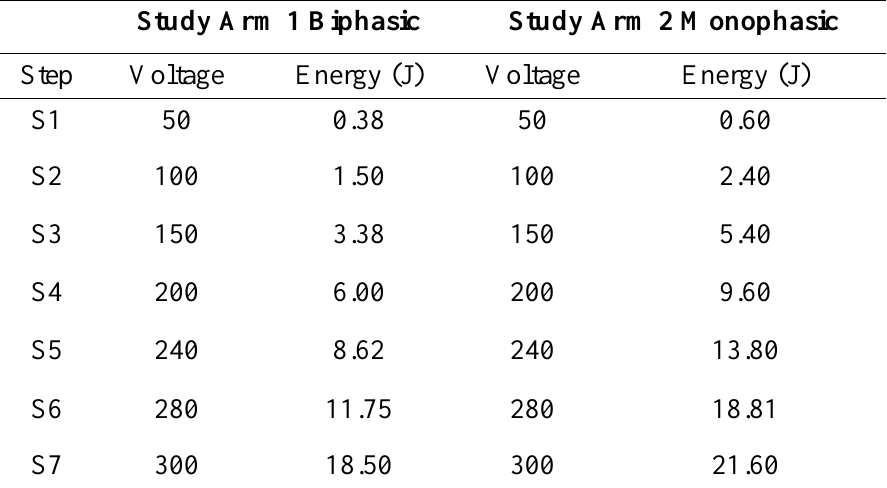
Table 1. Step up protocol with voltage and related shock energy (50 Ω intracardiac impedance